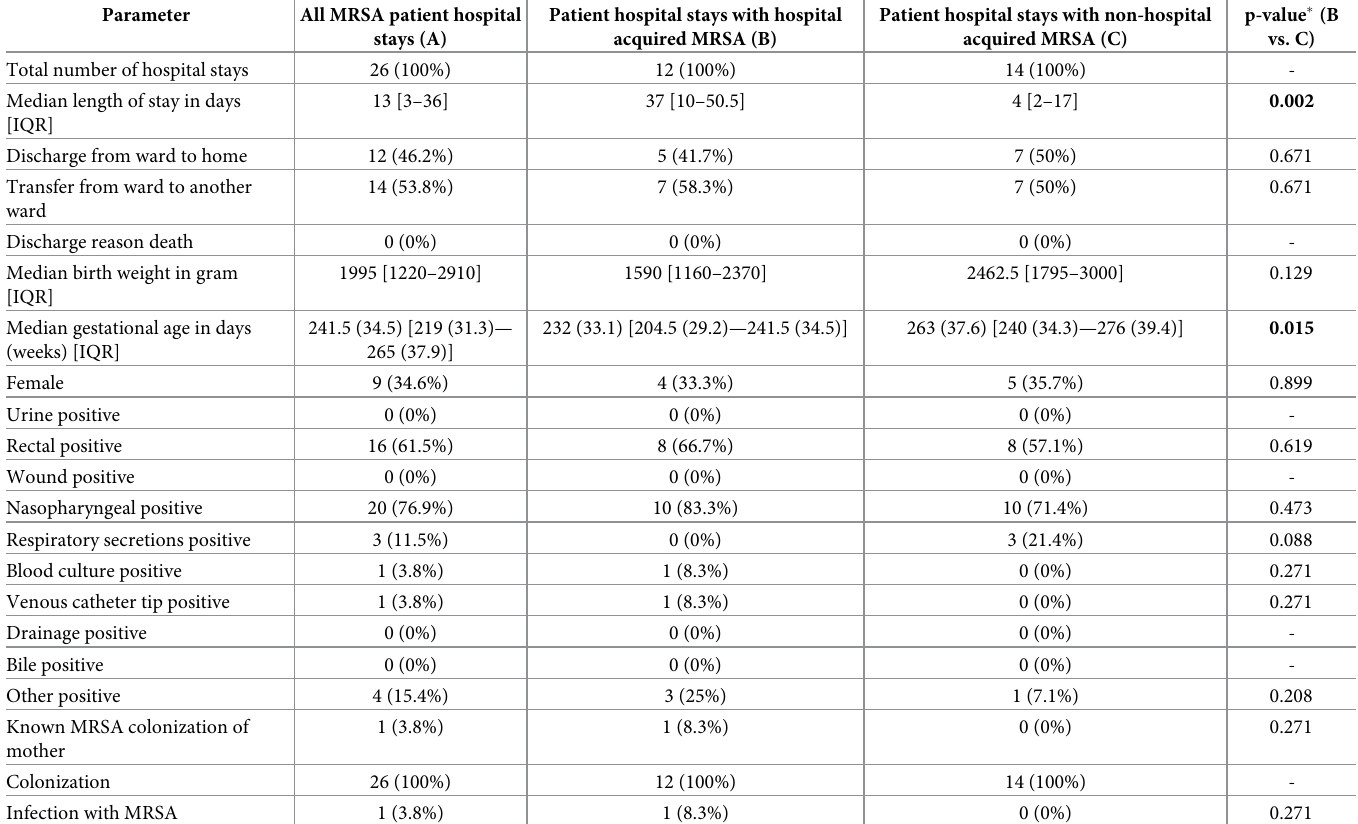
Table 1. Epidemiological and clinical characteristics of the MRSA